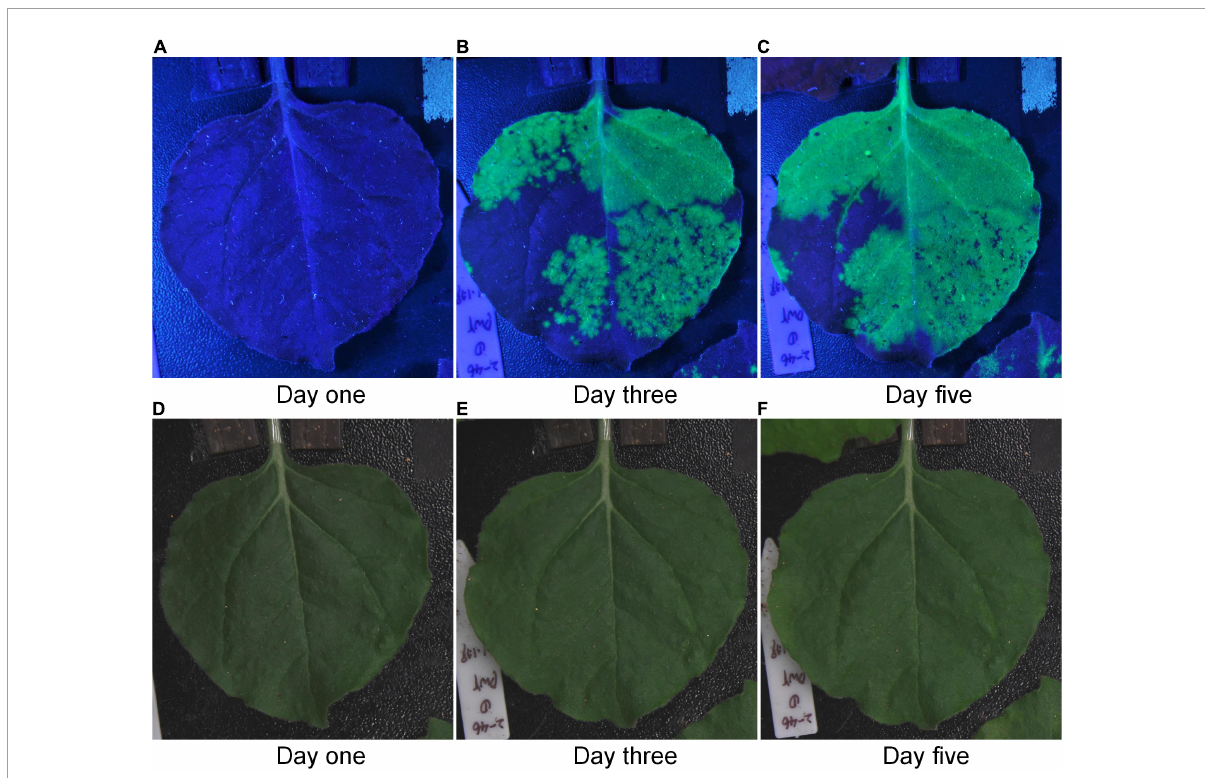
FIGURE5 The comparison of fluorescent images and RGB images of the same tobacco leaf. Panels (A–C) were fluorescent images. Panels (D–F) were RGB images.